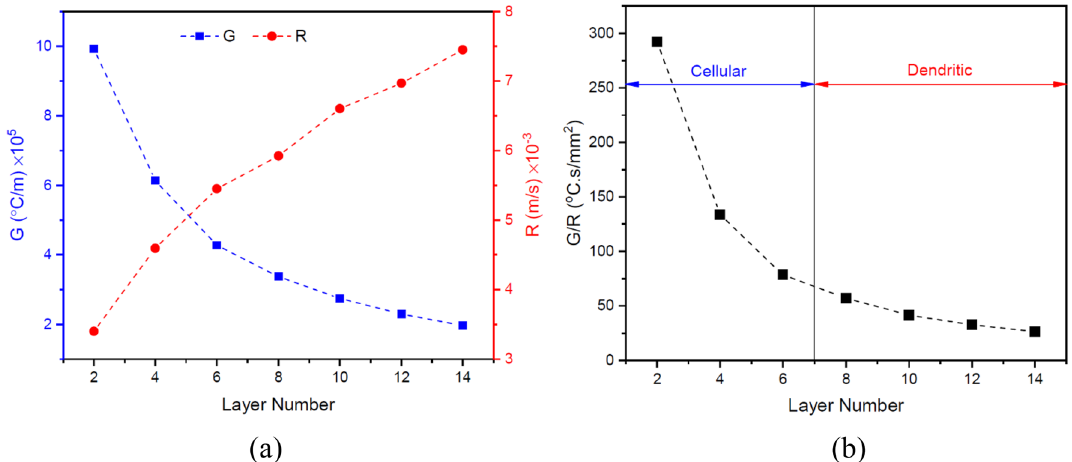
Figure 13. The variations of ( a ) temperature gradient ( G ) and solidification rate ( R ) and ( b ) undercooling ( G / R ) in the build